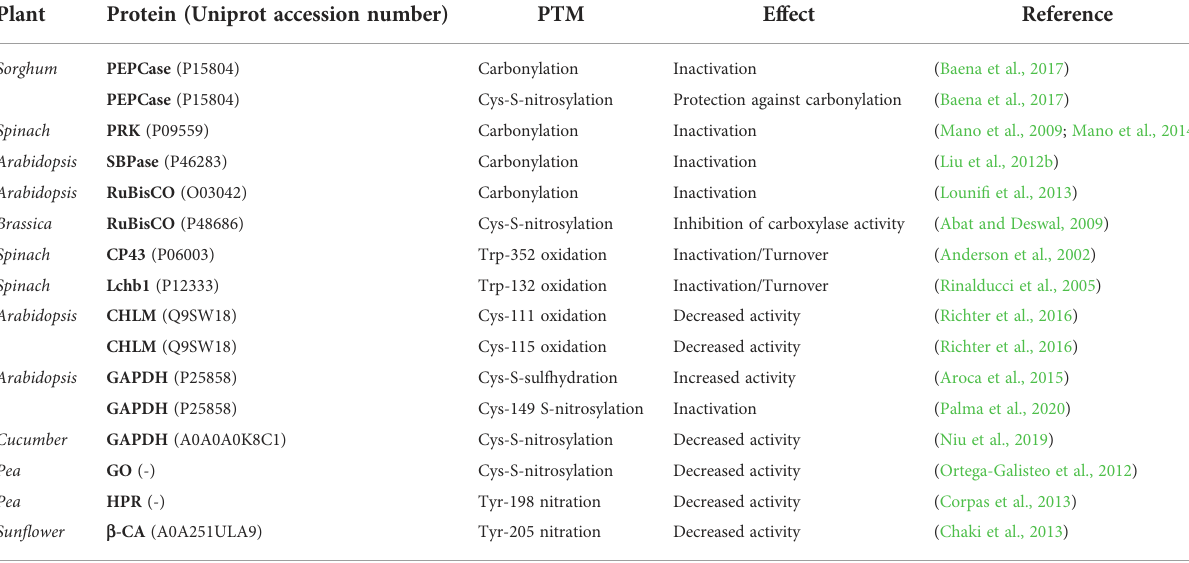
TABLE 4 PTMs and their effect on proteins involved in photosynthetic metabolism, photorespiration and Calvin-Benson cycle.